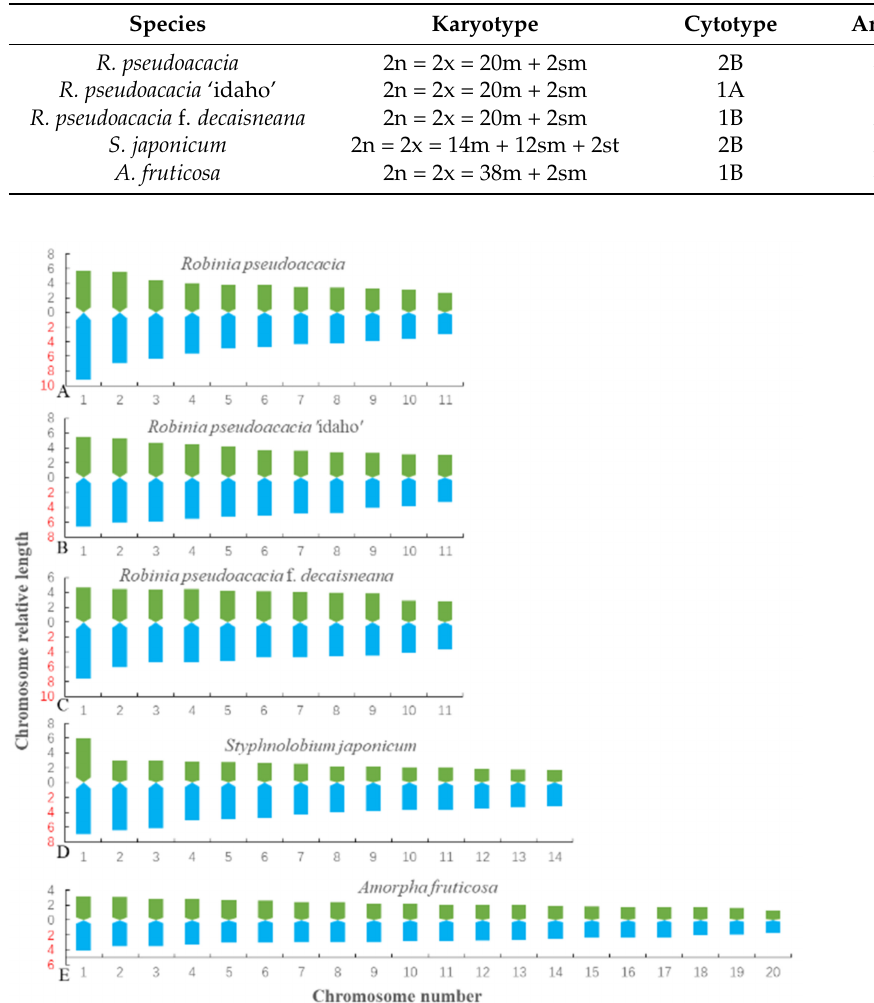
Figure 3. Karyotype ideograph of five Fabaceae. ( A ) R. pseudoacacia , ( B ) R. pseudoacacia ‘idaho’, ( C ) R. pseudoacacia f. decaisneana . ( D ) S. japonicum , and ( E ) A. fruticose . The x -axis indicates chromosome number, whereas the y -axis indicates relative chromosome length. The data were from Table 1 in order to better display the relative chromosome length of five